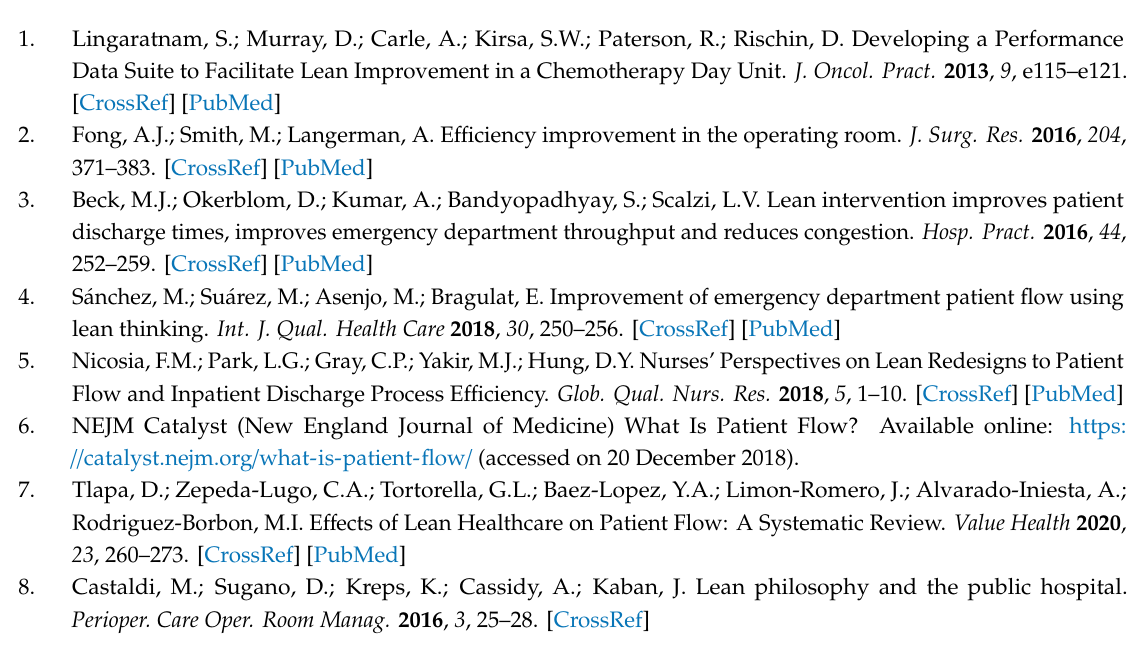
Table S1: PRISMA checklist, Data S1: Search strategy, Table S2: Geographical distribution of studies selected, Table S3: Distribution per year of studies selected, Table S4: Summary of findings of LH, and Table S5: Risk of bias. Author Contributions: Conceptualization, C.Z.-L and D.T.; methodology, D.T. and Y.B.-L.; formal analysis, C.Z.-L., D.T., Y.B.-L., J.L.-R., S.O.; investigation, C.Z.-L., D.T., A.P.-S., and G.T.; writing—original draft preparation, C.Z.-L., D.T., J.L.-R., and A.P.-S.; writing—review and editing, S.O. and G.T.; supervision, D.T., Y.B.-L., S.O., A.P.-S., and